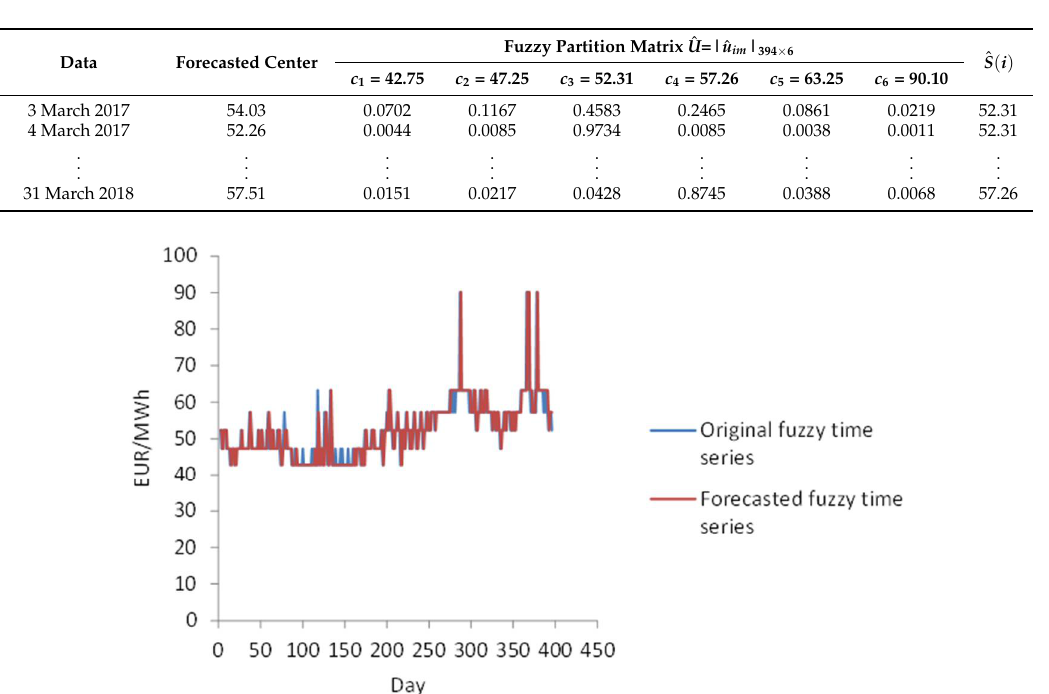
Figure 8. Original fuzzy time series and forecasted fuzzy time series of monitored electricity price. Absolute percentage error of the model for 4 March 2017 is: